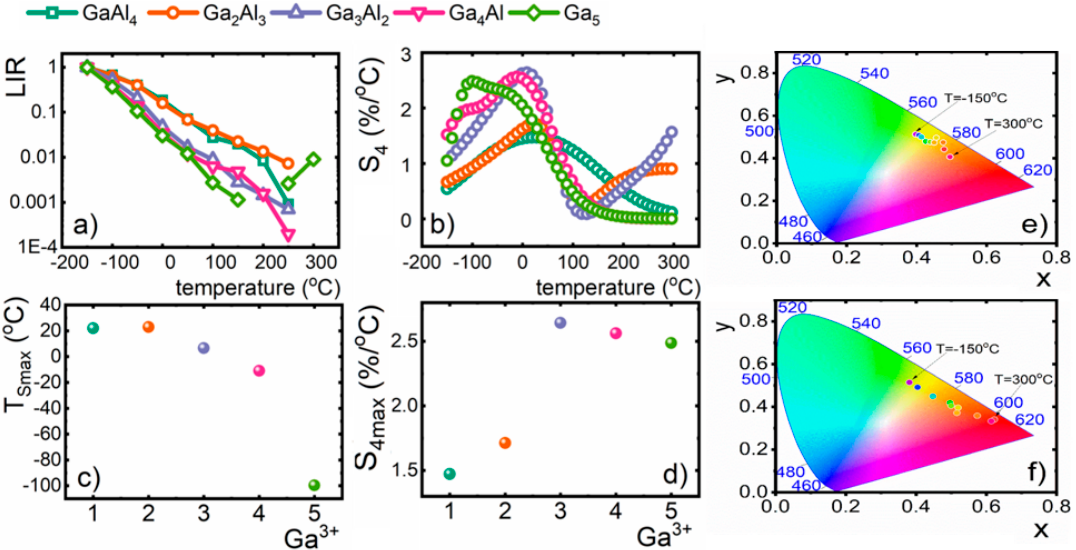
Figure 4. ( a ) Thermal evolution of luminescence intensity ratio (LIR); ( b ) their relative sensitivities for Y 3 Al 5 − x Ga x O 12 nanocrystals; ( c ) the temperature at which the maximal value of S 4 was observed; ( d ) S 4max as a function of Ga 3 + concentration; ( e , f ) the CIE 1931 chromatic coordinates calculated for Y 3 Al 4 GaO 12 :V and Y 3 AlGa 4 O 12 :V nanocrystals, respectively.